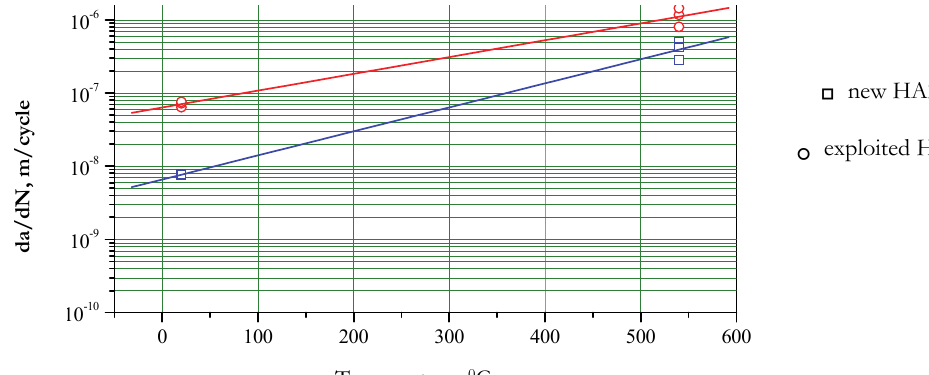
Figure 8: Fatigue crack growth rate, da/dN, vs. temperature for specimens with notches in HAZ.